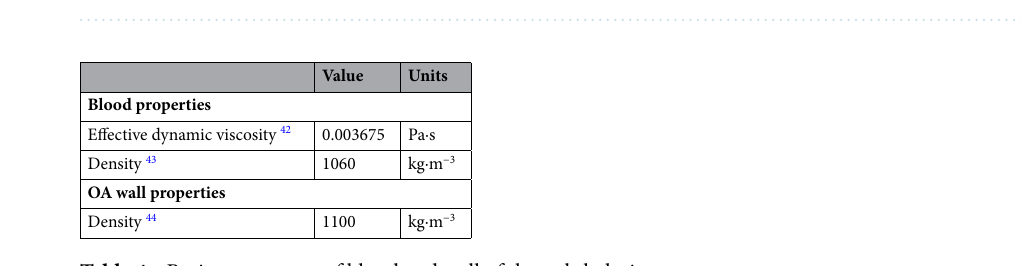
Table 3. Geometrical parameters of the ophthalmic artery. OA the ophthalmic artery, IOA intracranial segment of the ophthalmic artery, EOA extracranial segment of the ophthalmic artery, OC optic canal.